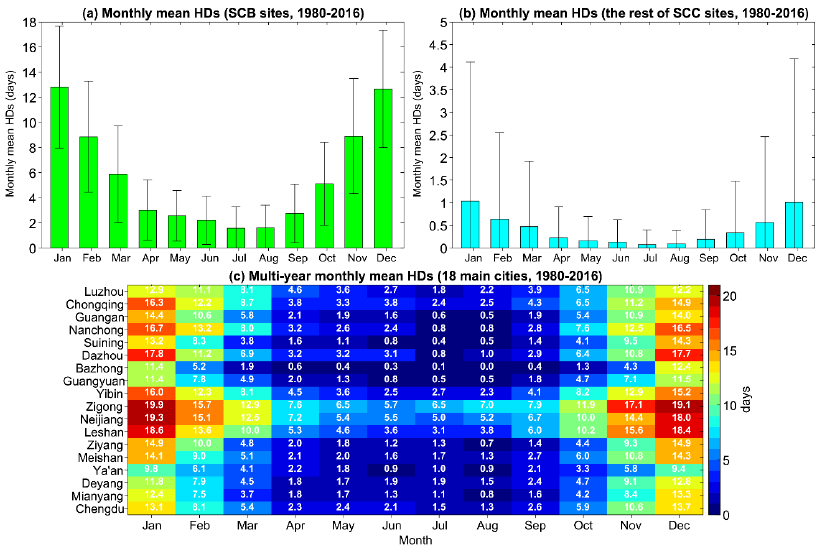
Figure 6. The multi-year (1980–2016) monthly mean variations in HDs averaged ( a ) for all stations in SCB and ( b ) for those in the rest of SCC region. ( c ) The monthly mean variations in HDs in 18 main cities of SCB for 1980–2016.